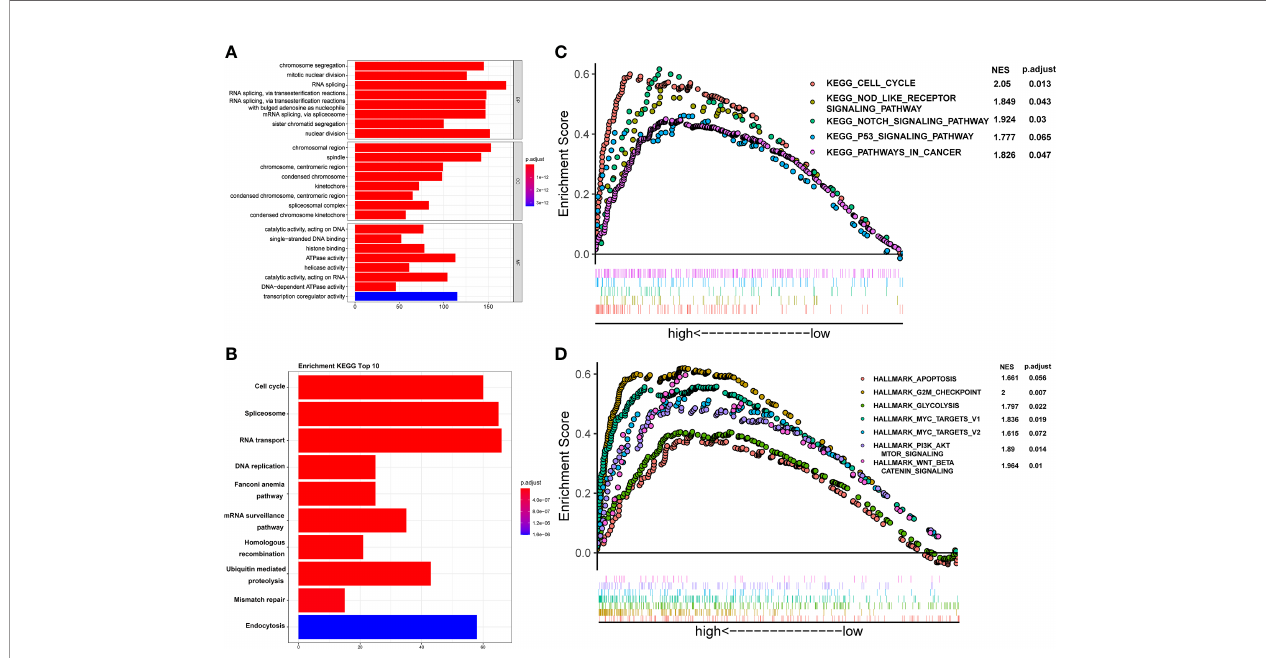
FIGURE 8 | Functional enrichment analysis of CSTF2 in the TCGA cohort. (A) GO classi fi cation analysis of gene changes in the biological process. (B) KEGG pathway enrichment analysis of upregulated pathways (C, D) GSEA analysis of activated pathways and hallmarks of CSTF2 related in HCC based on the TCGA